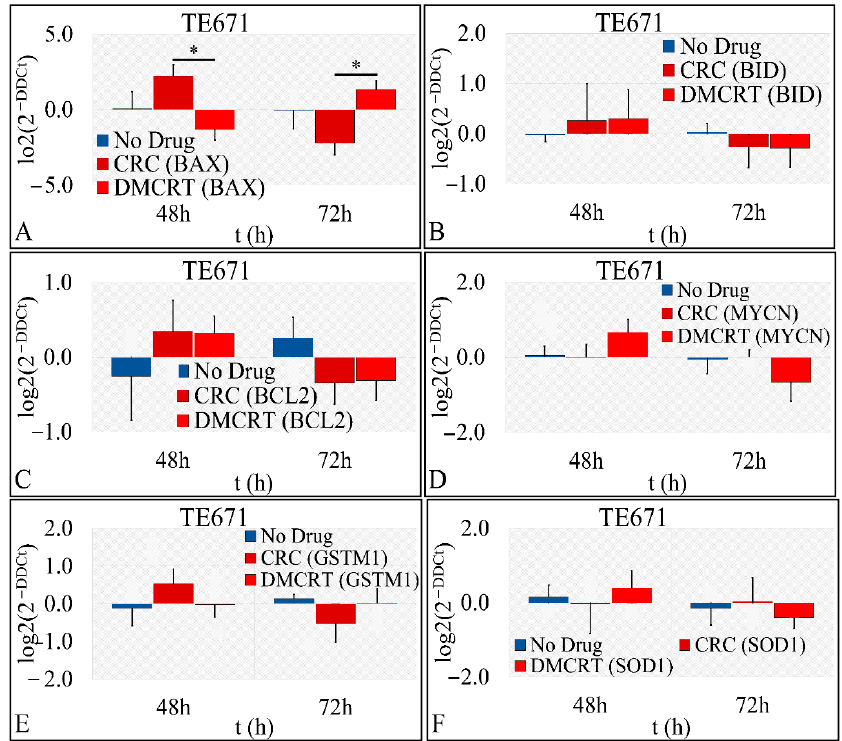
Figure 12. Gene expression under CRCs and DMCRT treatment for BAX ( A ), BID ( B ), BCL2 ( C ), MYCN ( D ), SOD1 ( E ) and GSTM1 ( F ) (* depicts a significance at the p < 0.05 level).